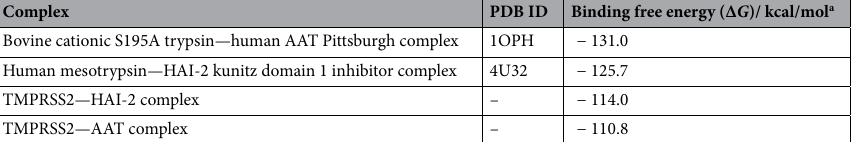
Table 1. Predicted binding free energies for representative protease-inhibitor complexes. a Calculations were performed using the Molecular Mechanics-Generalized Born and Surface Area (MM-GBSA) approach in BioLuminate (version 1.0, Schrödinger, LLC, New York, NY, 2012). Ranked according to Δ G: a more negative value indicates stronger